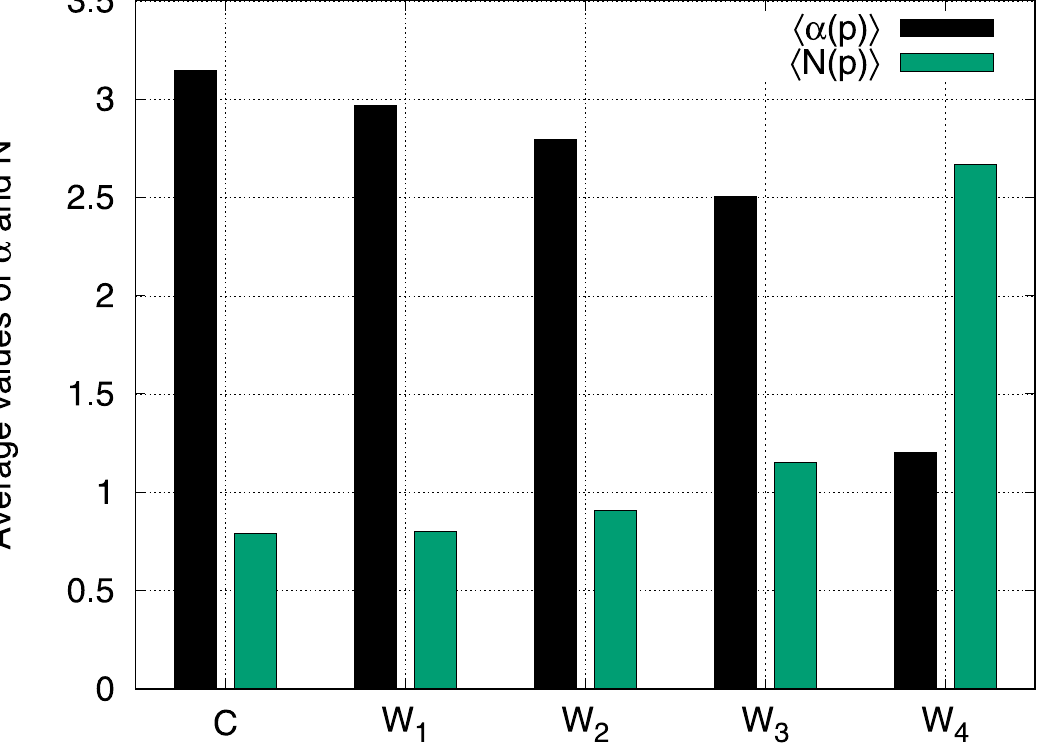
Fig 2. The average of both best score function, α ( p ), and numbers of HLAs a given peptide strongly binds, N ( p ), are reported for each peptide classes.